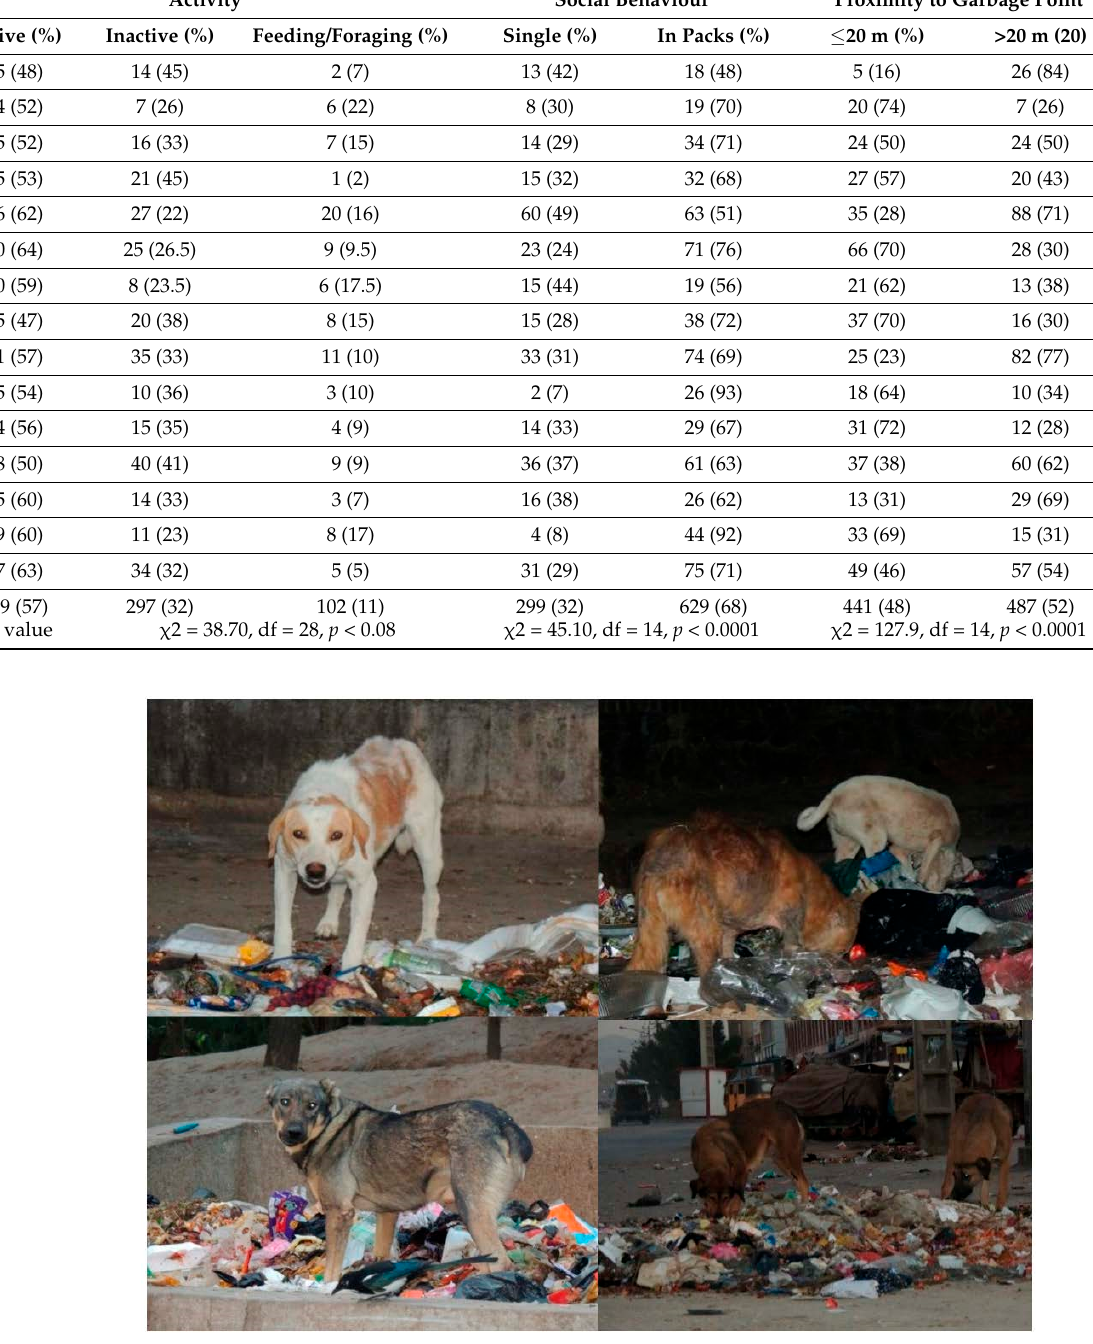
Figure 7. Images of FRDs in Herat city foraging edible materials from uncollected garbage along the streets and sidewalks.